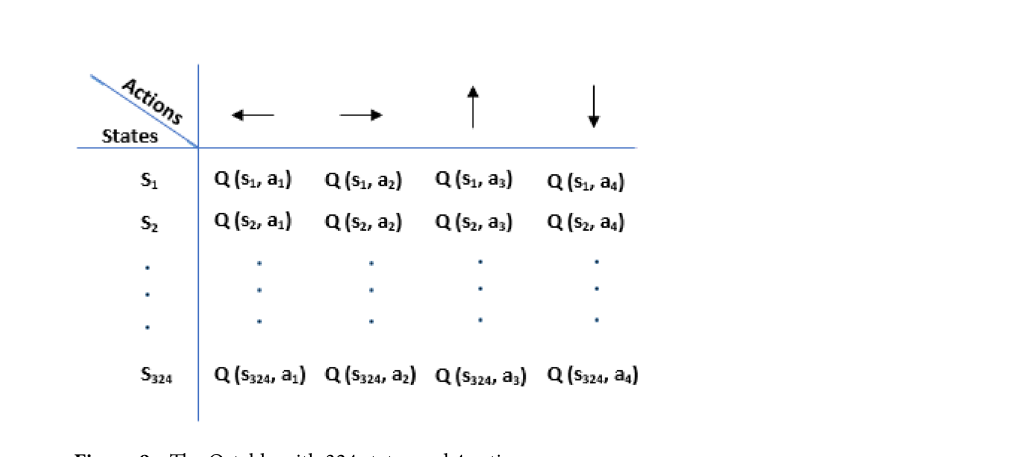
Figure 8. The 2D states table with 18 rows and 18 columns due to the second thickness of the moderator (PE) and the first thickness of the moderator (BeD 2 ), respectively.